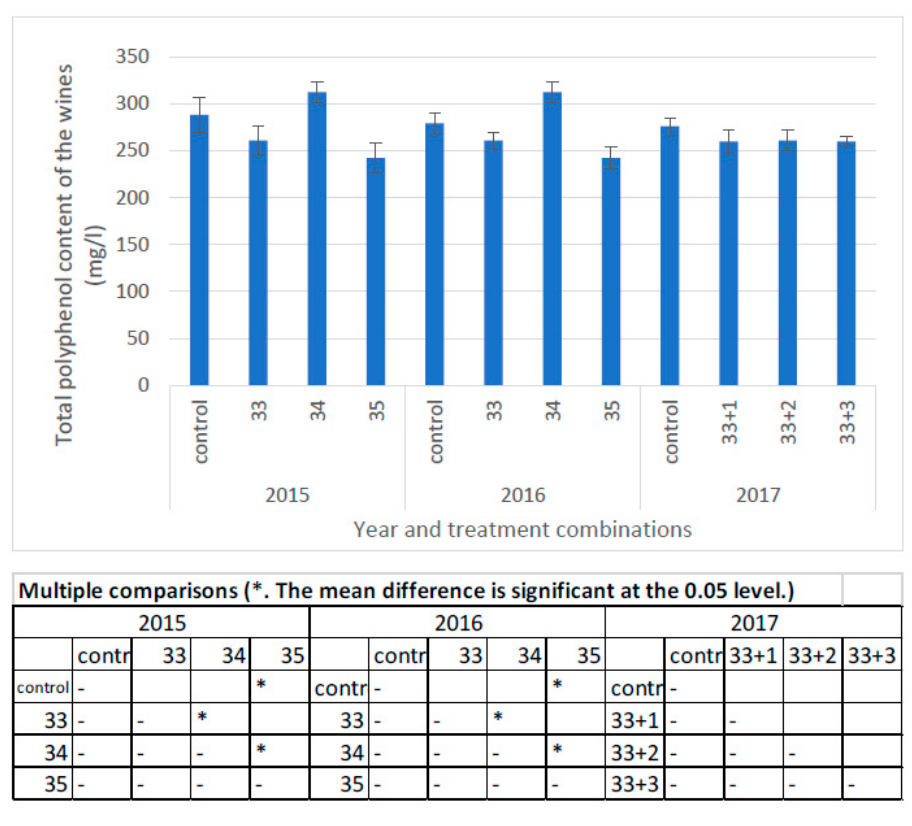
Figure 8. Total polyphenol content of the wines in 2015–2017 (mg/L).